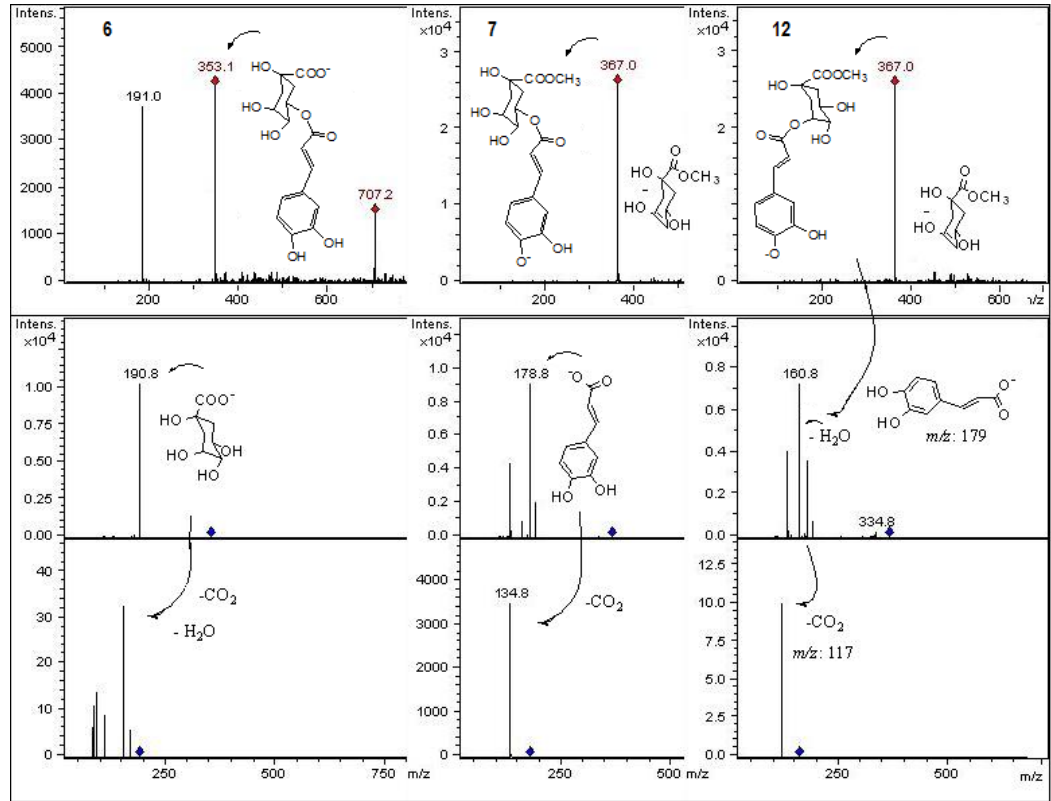
Figure 6. Structures, fragmentation, full ESI-MS and MS-MS spectra of peaks 6 , 7 and 12 .